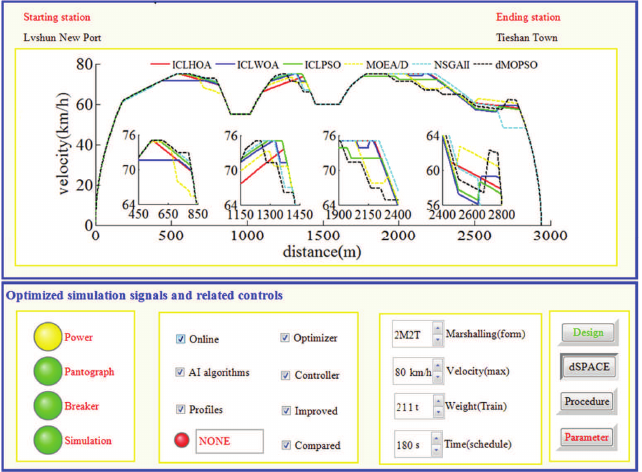
Figure 22. The control sequence distance curve obtained by different algorithms in ICL-HILS.